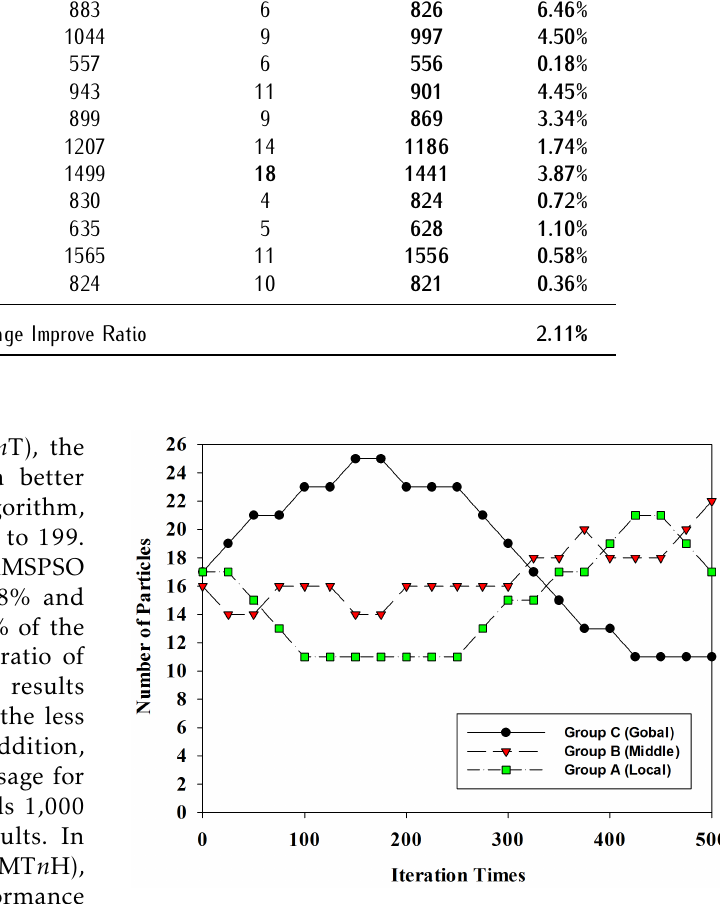
Figure 3. The simulation result of particle number changes PSO-RTVIWAC performs well for searching a better solution on middle area and local area. This